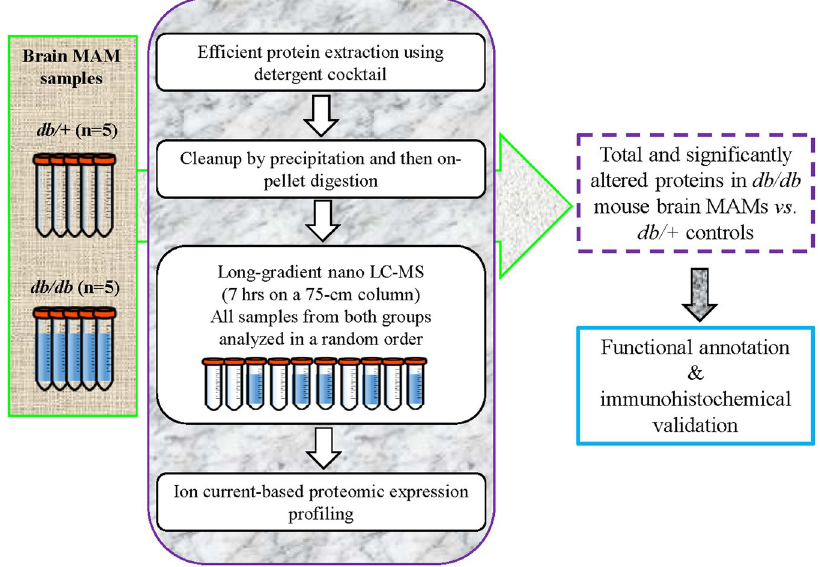
Figure 2. Scheme of proteomics strategy applied to analysis of mouse brain MAM samples from db/db mice vs . age- and gender-matched db/ + mice. A highly reproducible and extensive ion-current-based quantification method, known as long gradient nano-reverse-phase liquid chromatography/mass spectrometry, was applied in the analysis of the 5 biological replicates. David bioinformatics database (6.7, NIAID/NIH) and Ingenuity Pathway Analysis (IPA) were used for the function annotation of the identified proteins. The pathways and proteins of high interests were verified by immunohistochemical studies in the